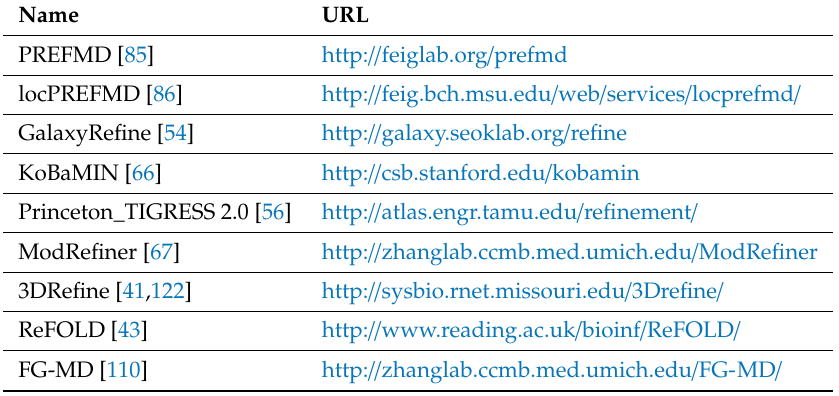
Table 1. Publicly-available refinement web servers, based on methods tested in the CASP